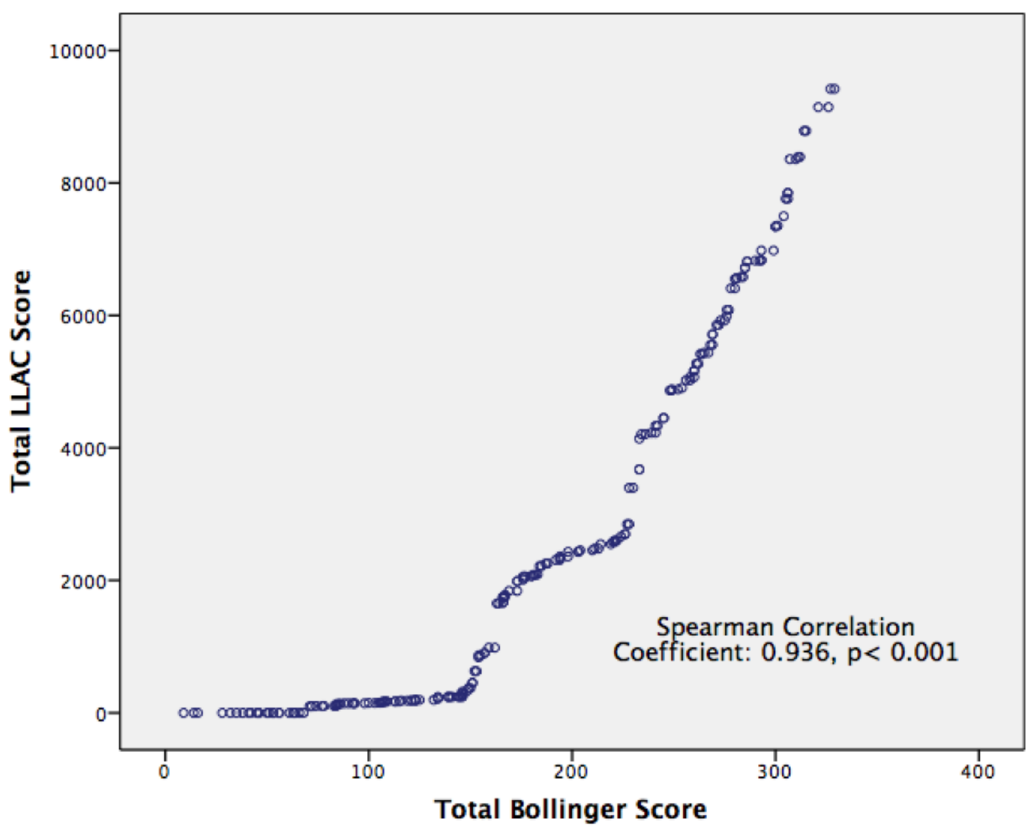
Fig 3. Correlation between total LLAC and Bollinger scores in patients with symptomatic peripheral arterial disease. Statistical analysisperformed using Spearman’s rank correlationcoefficient. p < 0.05taken to be statistically